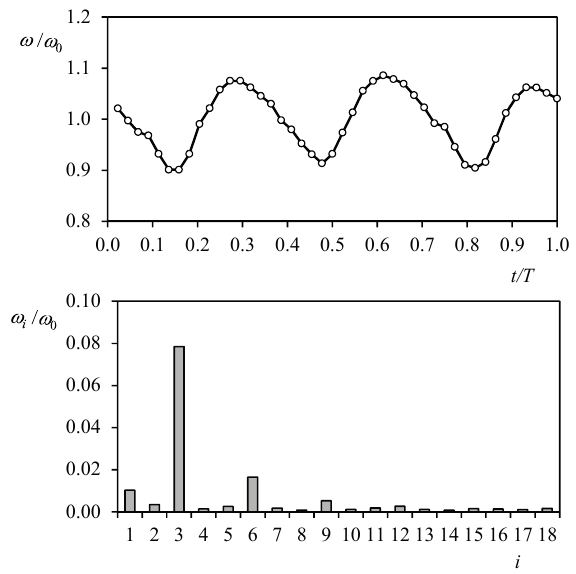
Figure 15. Relative-to-the-average rotational speed, ω / ω 0 , of a Thies 4.3303 anemometer during one turn at 8 m/s wind speed [75] ( Top ); and non-dimensional values of the Fourier series decomposition performed on that rotational speed, ω i / ω 0 ( Bottom ), see Equation (42). T is the period of the anemometer’s